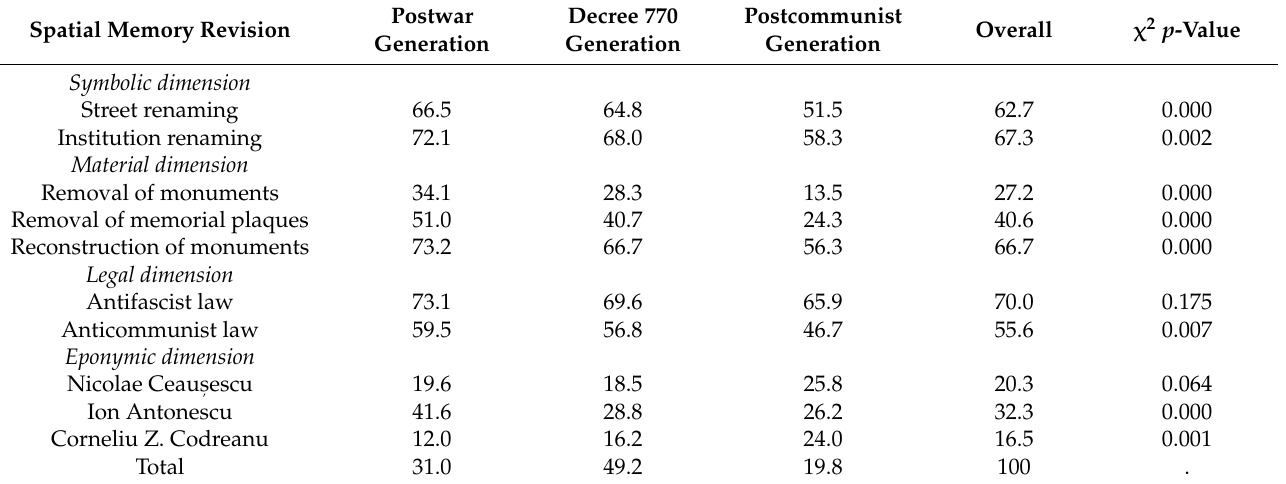
Table 2. Support for the reconfiguration of spatial memory after 1989